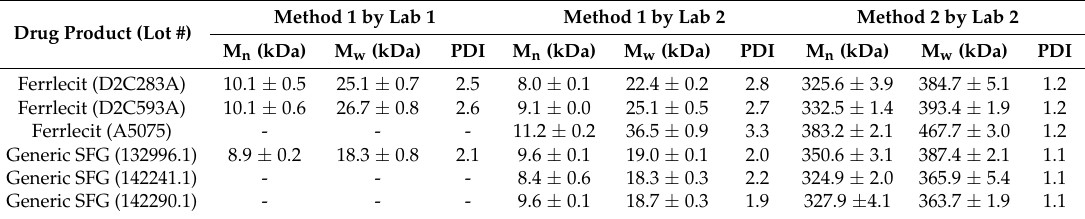
Table 6. Gel permeation chromatography (GPC) results of number-average molecular weight (M n ), three generic SFG lots using two methods (Section 2.4.1) conducted by two independent labs. Method 1 by Lab Drug Product (Lot #)